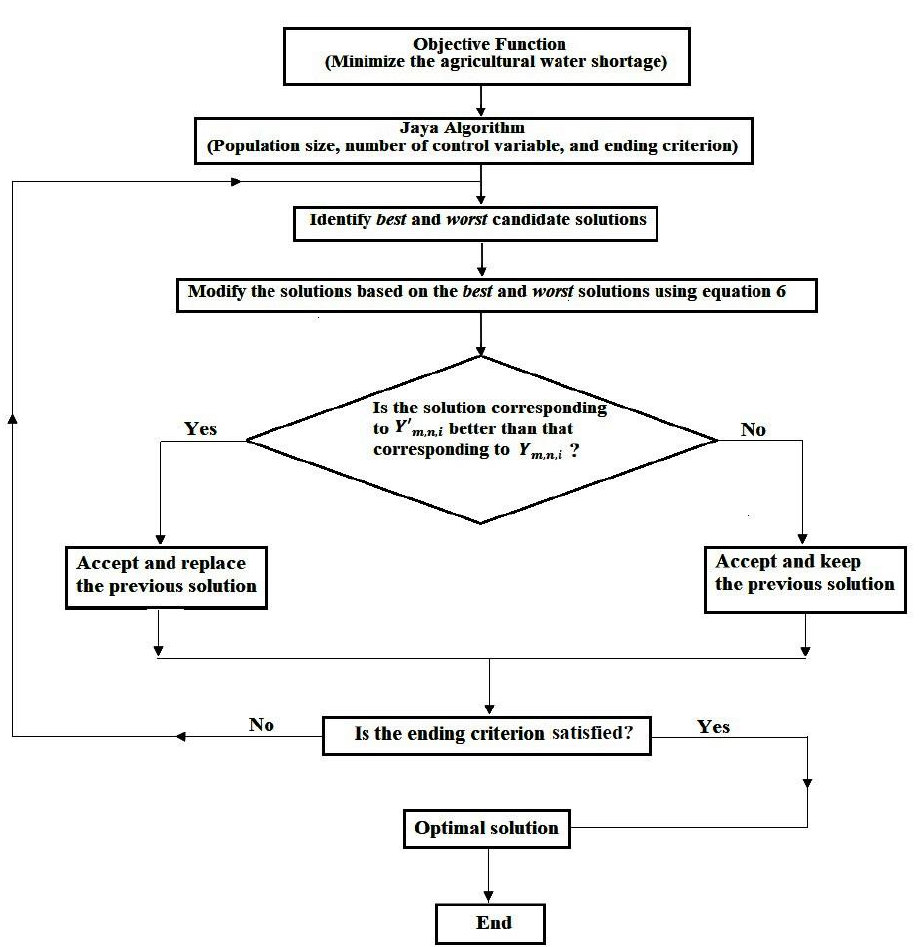
Figure 6. Process flow of the JA.